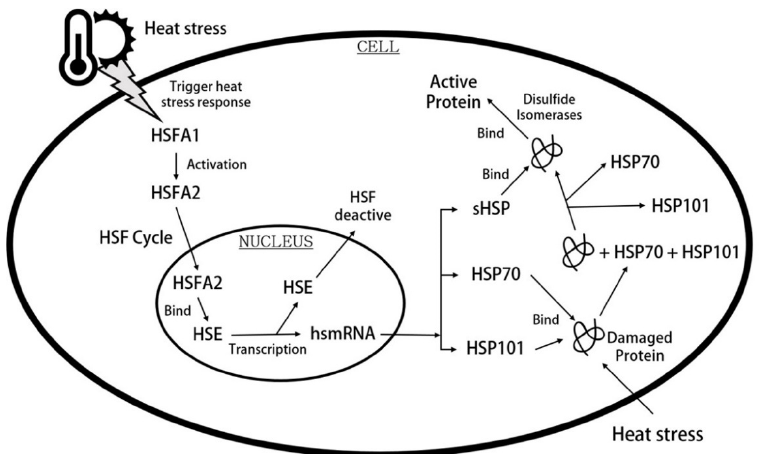
Figure 7. Diagram of the heat-shock protein pathway. HSFA1, one of the heat-stress factors (HSFs), triggers a heat-stress response by inducing the expression of HSFA2, which forms co-activators. HSFA2 binds to a heat-shock promoter element (HSE), which then induces the expression of various heat-shock proteins (HSPs). HSP101, HSP70, and sHSP help to repair damaged proteins. Adapted from Asthir [71].